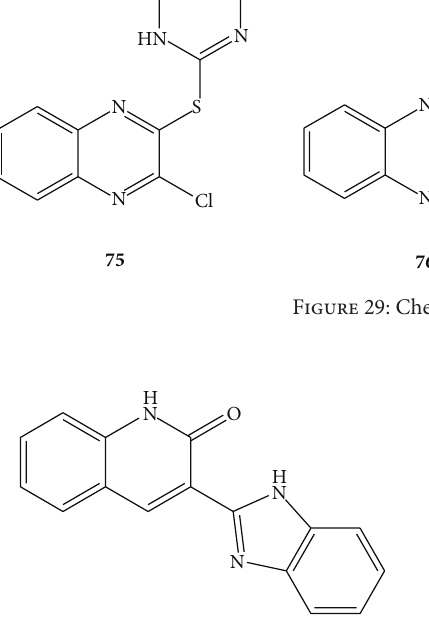
Figure 30: Chemical structure of compound 78 .